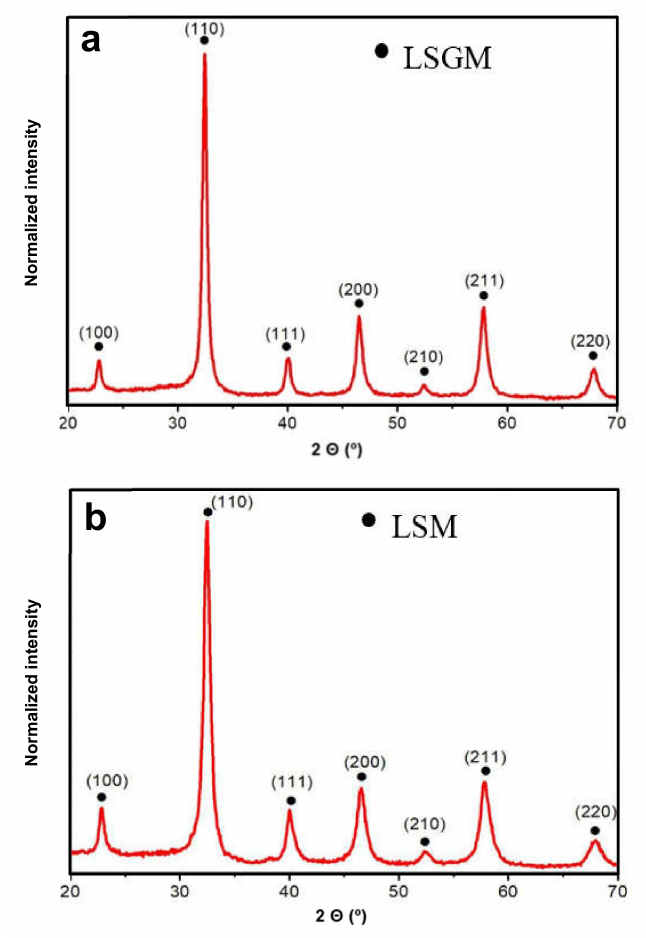
Figure 1. X-ray di ff raction patterns of La 0.8 Sr 0.2 Ga 0.8 Mg 0.2 O 3- δ (LSGM) ( a ) and La 0.8 Sr 0.2 MnO 3 (LSM) ( b ) samples synthesized by mechanochemistry, (hkl) indices are